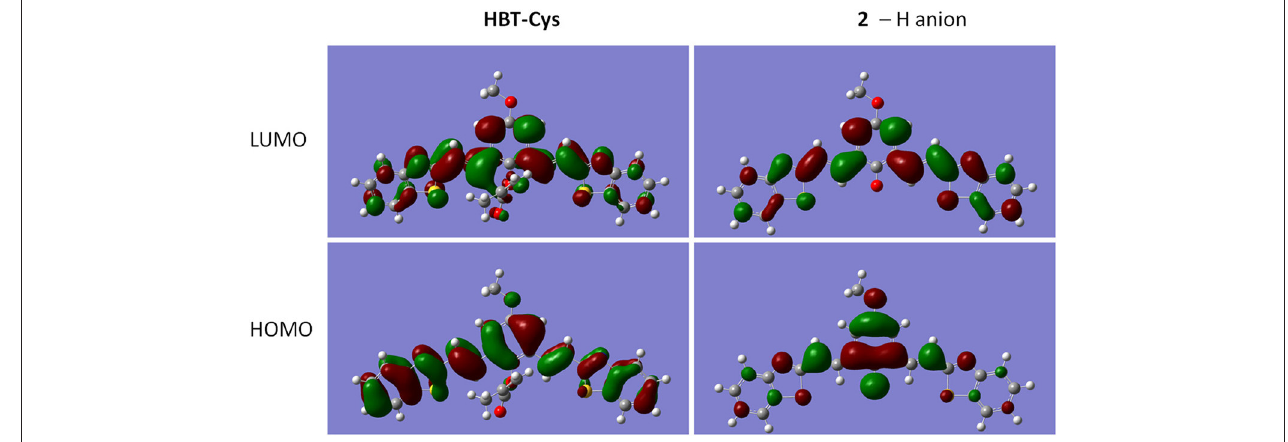
FIGURE 2 | LUMO and HOMO orbitals of HBT-Cys and 2 –H anion in the ground state.